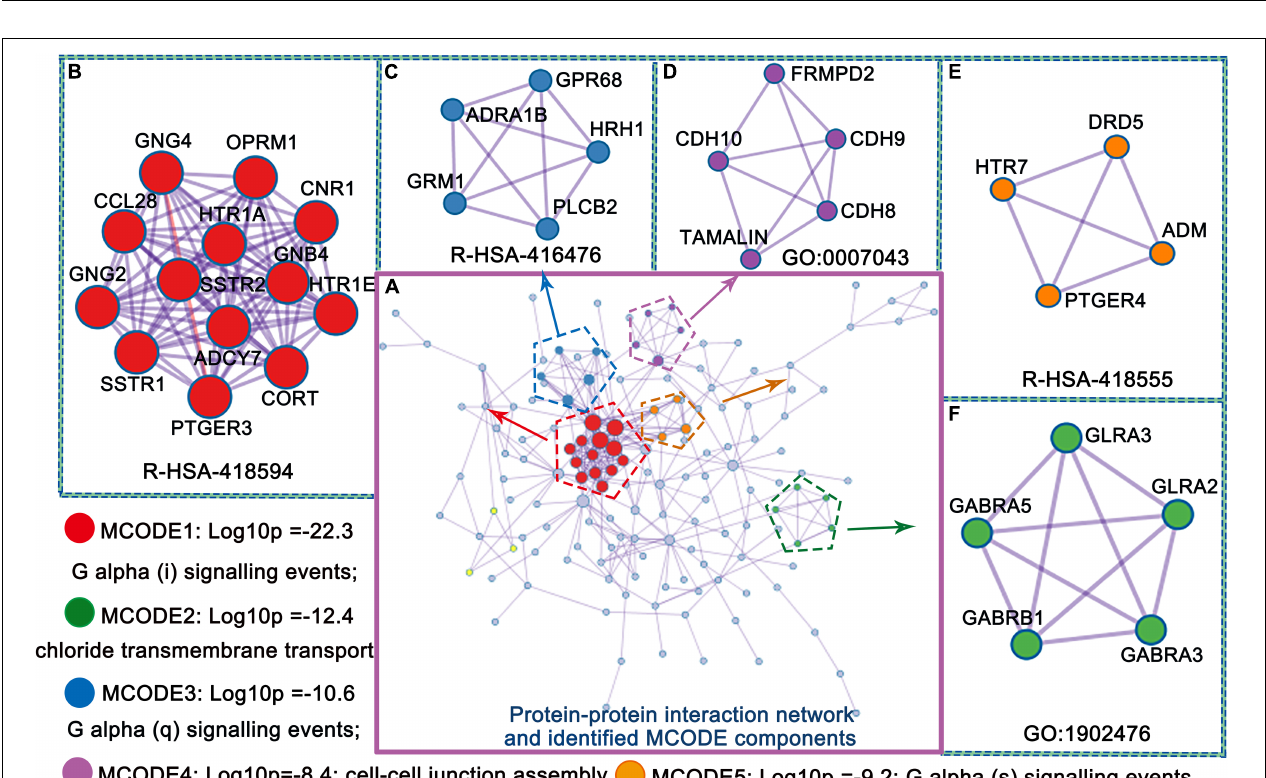
FIGURE 4 | Protein–protein interaction network and identified MCODE components (A–F) from PLS1 gene enrichment.